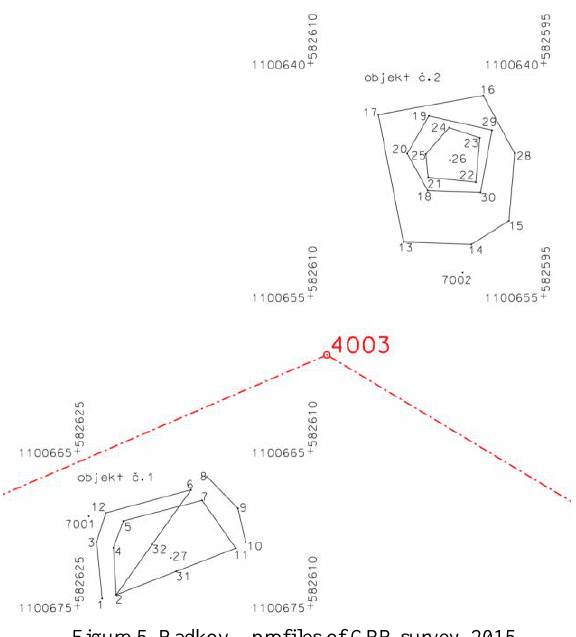
Figure 3. Radkov – GDEM, hillshade – Azimuth: 270° and Altitude: 45°, 2004